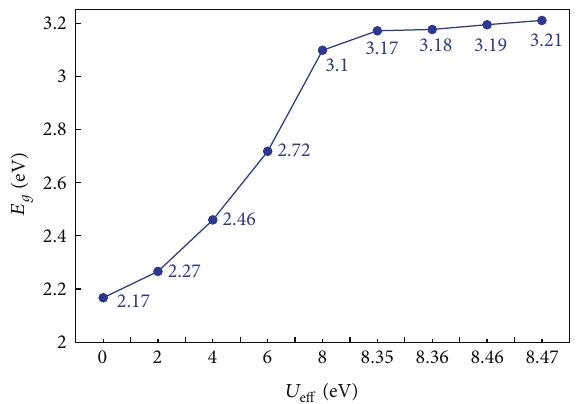
Figure 2: Relationship between the effective Hubbard parameter ) and the band gap ( 𝐸 𝑔 ) of anatase TiO 2 . ( 𝑈 eff